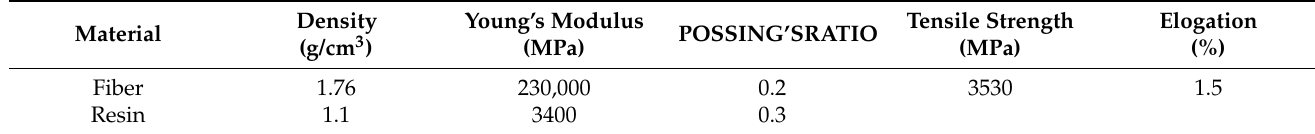
Table 3. Basic physical property DB of fibers and resins for use in Digimat